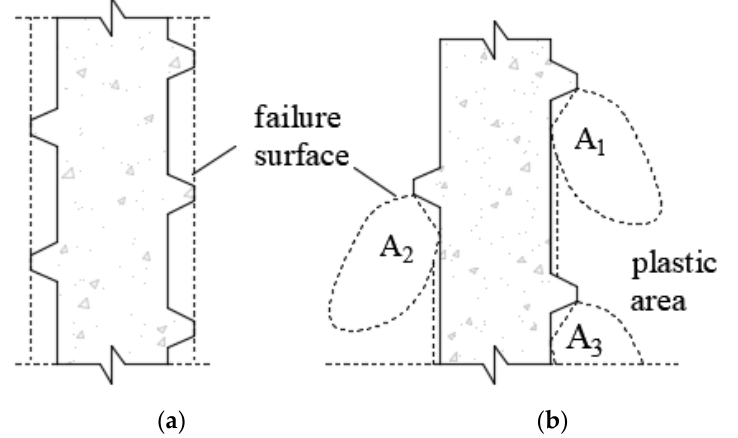
Figure 10. Failure modes of the screw pile. ( a ) CSF and ( b ) IBF.